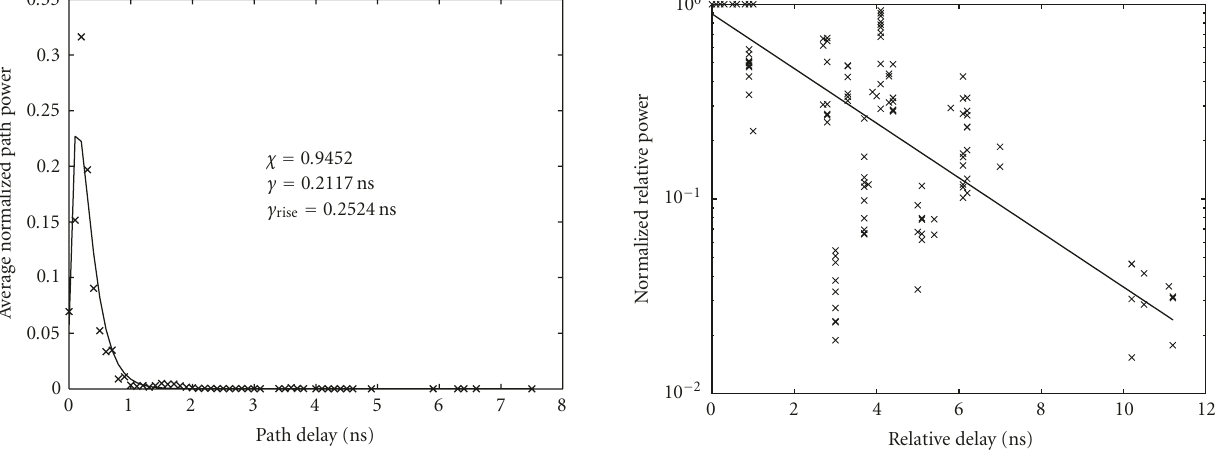
Figure 22: Normalized cluster power decay for measurements from the Taurus engine compartment.